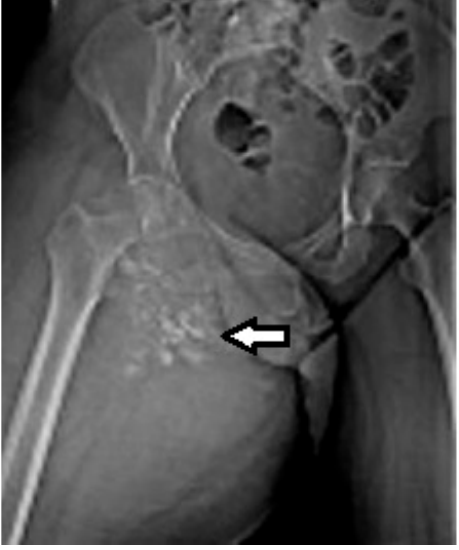
Figure 1. Synovial sarcoma, F, 40 YO—radiological AP view of the right hip and proximal thigh (prior to CT exam) reveals the presence of soft tissue calcifications medial to the lesser trochanter.